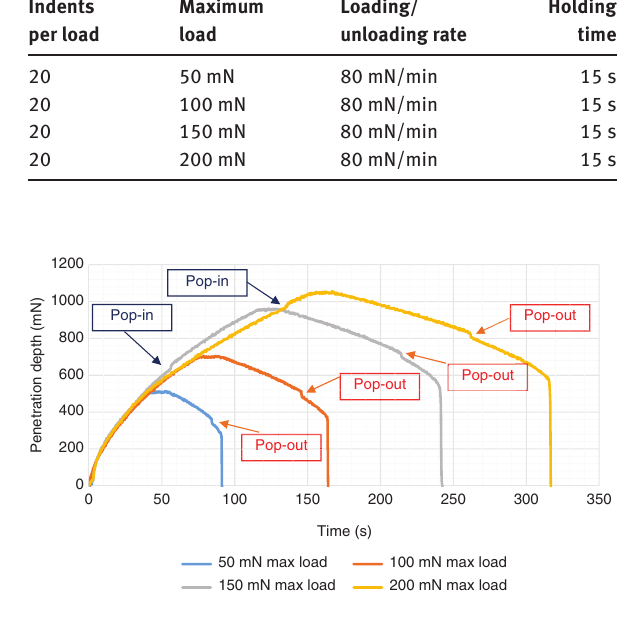
Figure 2: Penetration depth versus time curves of silicon wafers for four different loads, from 50 mN to 200